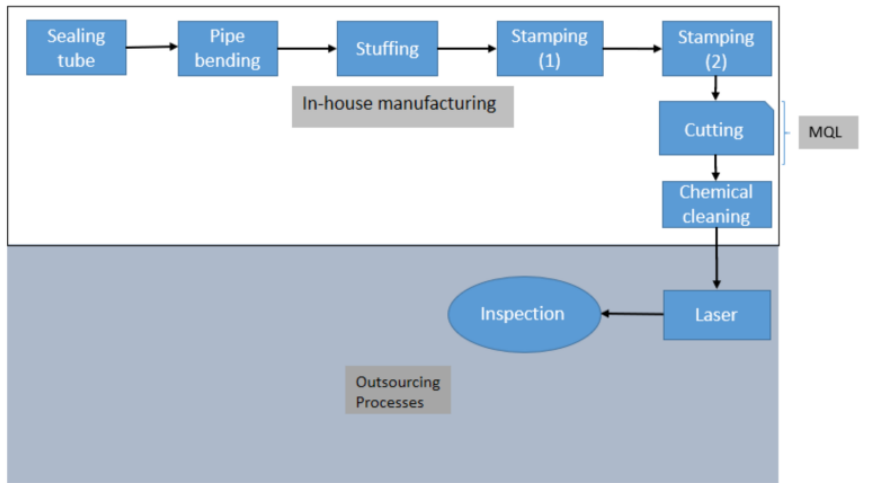
Figure 2. Production flow of automobile